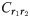
Phase only correlation.Result of the POC operation between two RT descriptors r1 and r2. The original images f1 and f2 were captured on the same point of the floor plane with orientations θ1 and θ2 respectively. The RT descriptors of these images are r1 and r2 respectively. The result of the POC operation between r1 and r2 is the matrix Cr1r2, whose elements take values between 0 and 1. These values are shown in a colour scale. The maximum value in Cr1r2 is a measure of similitude between r1 and r2 (the higher value the maximum component takes, the most similar both matrices are) and it is independent on the change of orientation. The position of the maximum value permits estimating the relative orientation of the robot when capturing both initial images θ21 = θ2 − θ1.